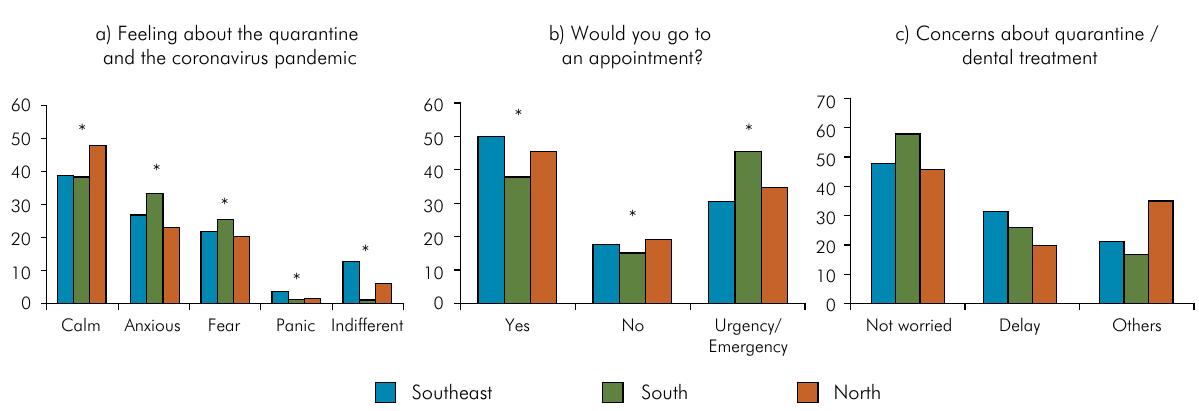
Figure 5. Comparison between